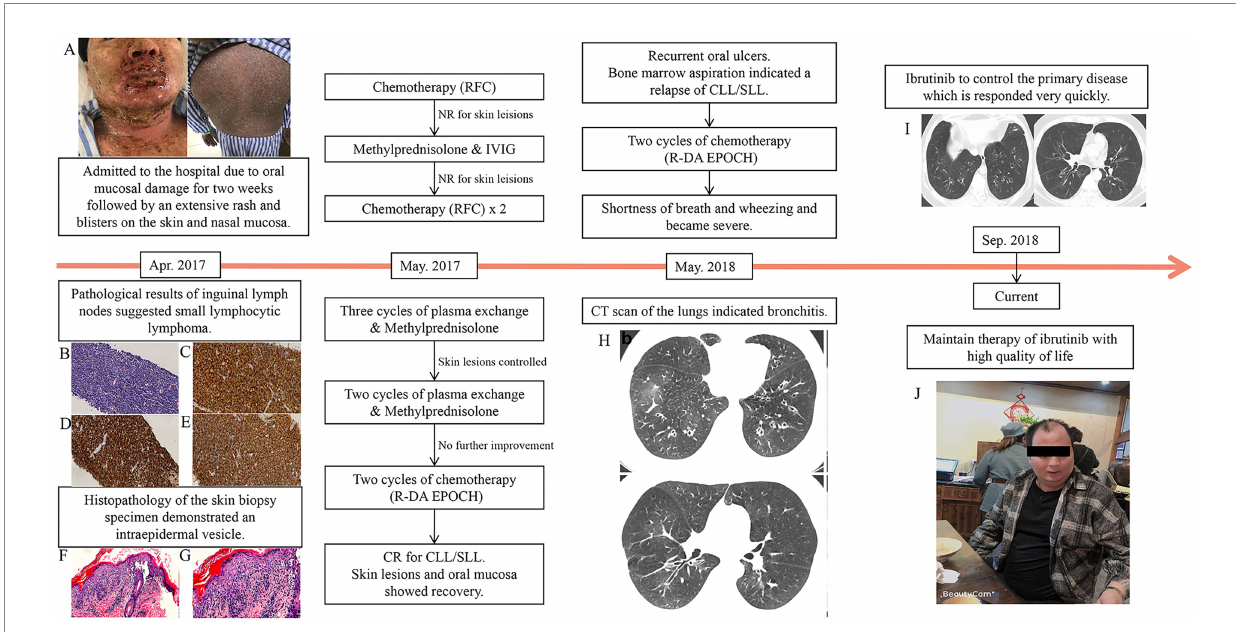
FIGURE 1 The patient’s clinical evaluation and treatments. (A) Pemphigus lesions on the skin and lip were extremely severe before treatment. A lymph node biopsy revealed (B) small B-cell lymphoma (magnification, ×400). Positive immunohistochemical results were observed for (C) CD5 (magnification, ×400), (D) CD20 (magnification, ×400), and (E) CD23 (magnification, ×400). Skin biopsy specimens demonstrating intraepidermal vesicle [ (F) (magnification, ×200)]. During the treatment of the relapse period, the patient developed shortness of breath and wheezing. (G) At the onset